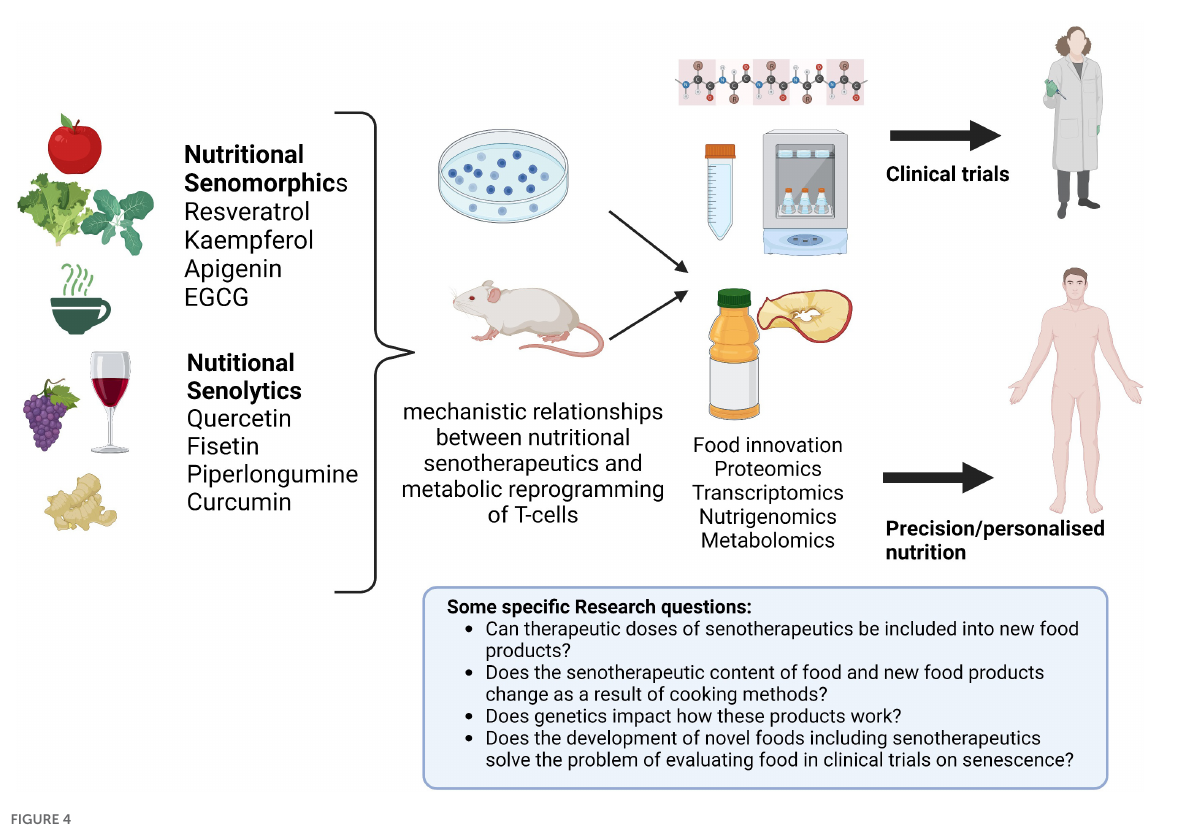
FIGURE4 Future approaches in nutritional senotherapeutics. Cellular and animal models may contribute to elucidating the role of nutritional senotherapeutics in T-cell reprogramming and serve as a basis for the development of new food products that can be tested in clinical trials and subsequently integrate personalized nutrition schemes. Created with